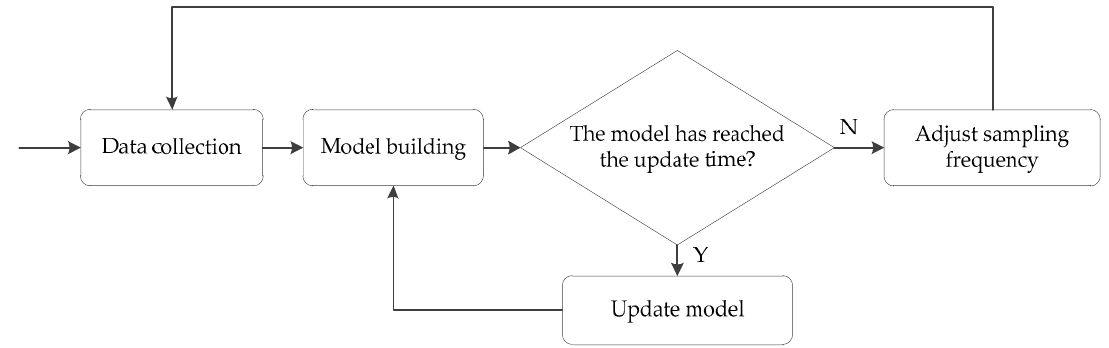
Figure 3. The illustration of the establishment of acquisition process.